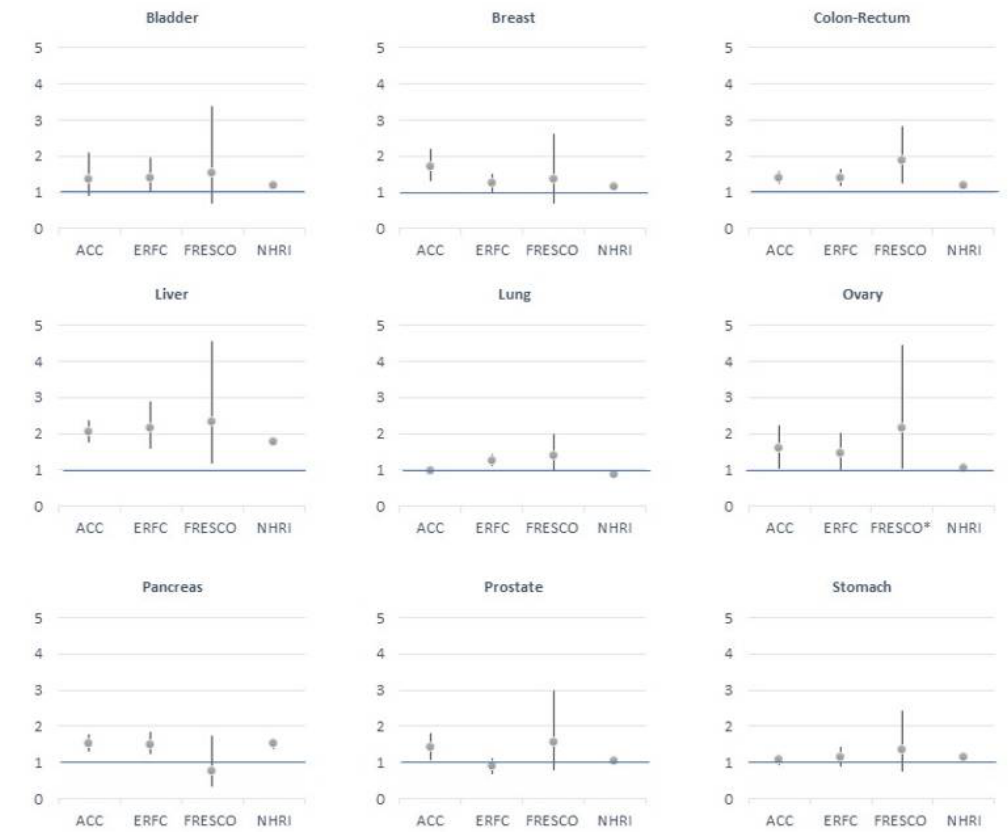
Figure 2. Hazard ratios for death from cancer in high-risk locations in individuals with type 2 diabetes mellitus. Data extracted from the Asia Cohort Consortium (ACC) [20], Emerging Risk Factors Collaboration (ERFC) [17], Spanish Risk Function of Coronary Events and Others (FRESCO) [18] and National Health Research Institute (NHRI) [21]. * Includes all cancers located in female genital organs.